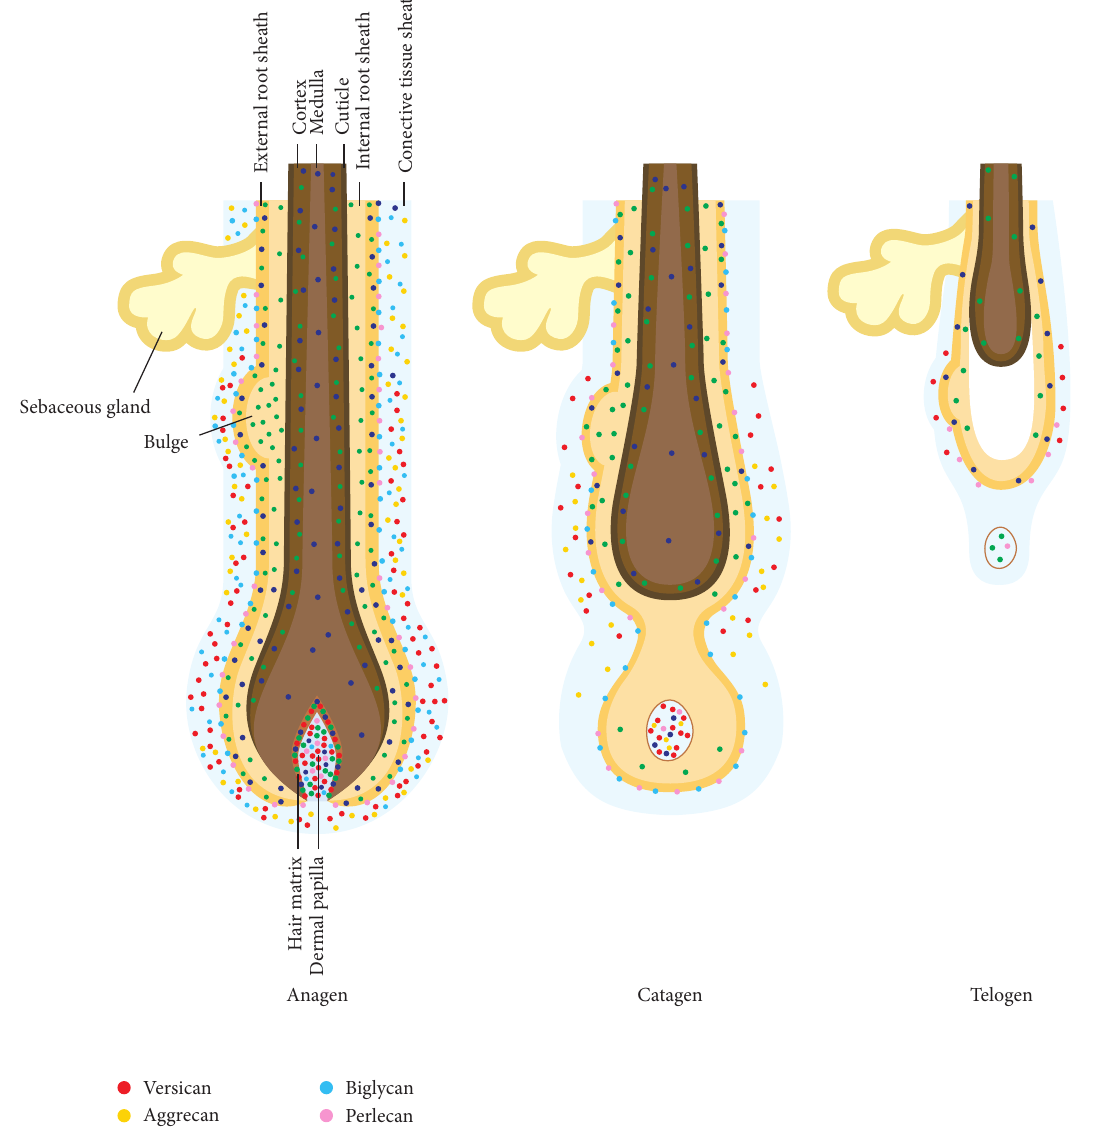
Figure 1: Redistribution of key follicular proteoglycans during the hair growth cycle, which supports their functional roles [12, 16, 21, 24,